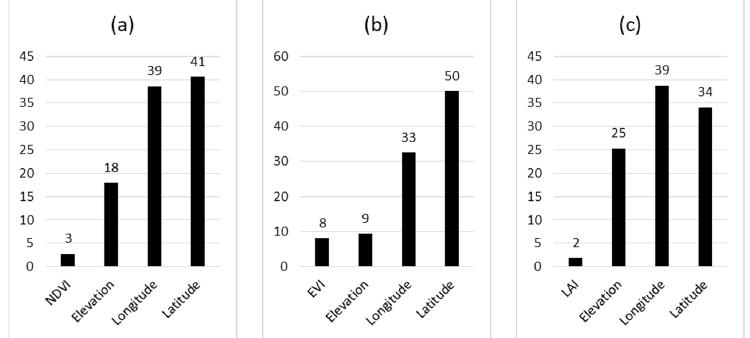
Figure 4. Importance scores of environmental variables for precipitation downscaling including elevation, longitude, latitude, and ( a ) NDVI, ( b ) EVI, and ( c ) LAI for the year 2018, illustrated by the “permutation importance” algorithm assigned by the ANN